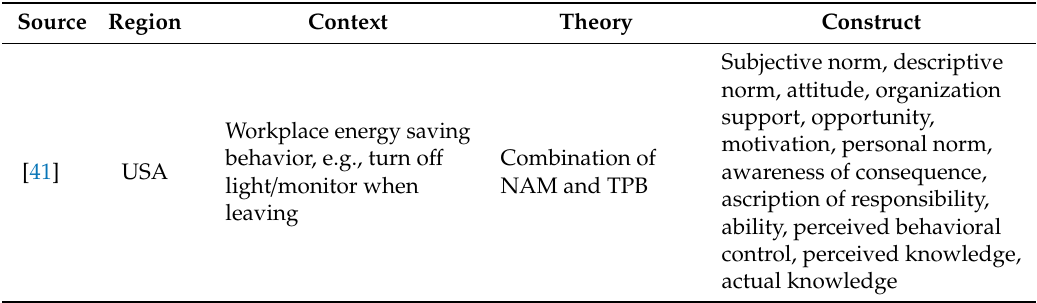
Table 1. A list of previous research about energy saving behavior with application of TPB and NAM. Source